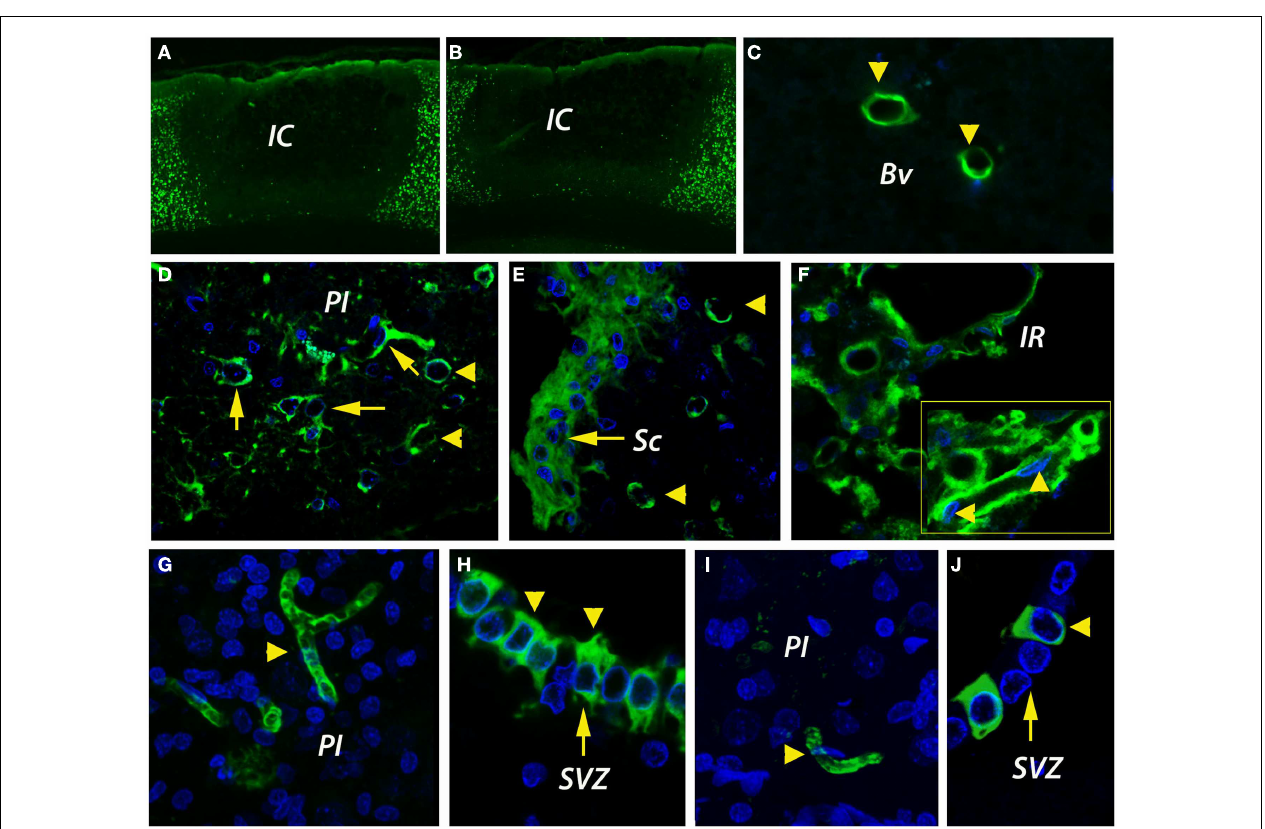
scar (E) . Beyond the fibrotic scar, however, in a region that we dubbed “islet of regeneration,” vigorous angiogenesis was detected in aged animals as well (F) . By day 14, mature BV had developed in the peri-infarcted area of young animals (G) . Similarly, new, mature blood vessels were detected in the same areas of the aged rats (I) . Please note the unexpected expression of CD31 in the wall of the subventricular zone both in young (H) and aged animals (J) . (C–J) are Z -projection images. BV, blood vessel; IC, infarct core; IR, islet of regeneration; PI, peri-infarct; Sc, scar; SVZ, subventricular